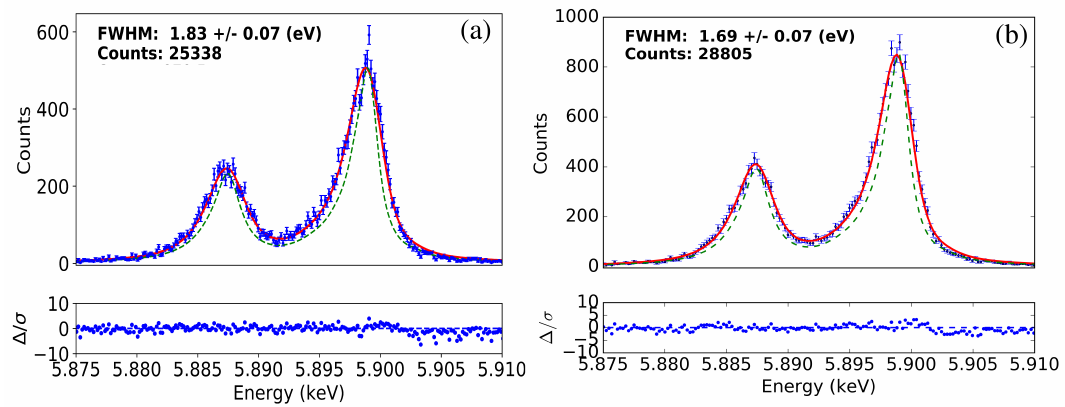
Figure 12. X-ray spectra of the Fe 55 − K α complex at 5.9 keV demonstrating excellent energy resolution with SRON high aspect ratio TESs: ( a ) 80 × 20 µ m 2 , R N = 100m Ω and bias frequency 2.5 MHz, and ( b ) 80 × 10 µ m 2 , R N = 200m Ω and bias frequency 3.5 MHz. The dashed green line is the natural lineshape of the